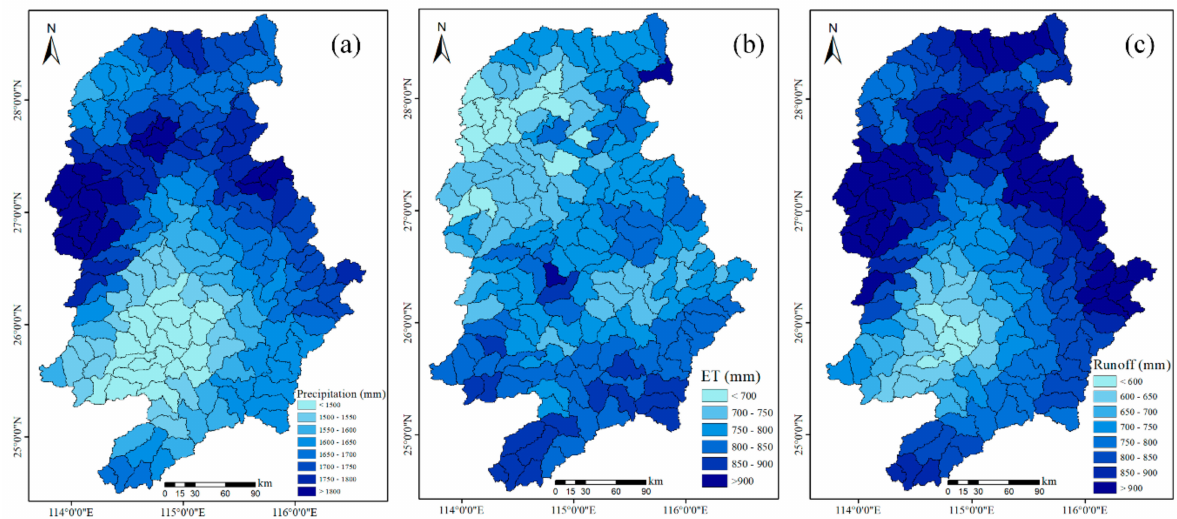
Figure 3. Spatial distributions in multi-year average (2002–2018) ( a ) precipitation, ( b ) ET, and ( c ) runoff in the Ganjiang River